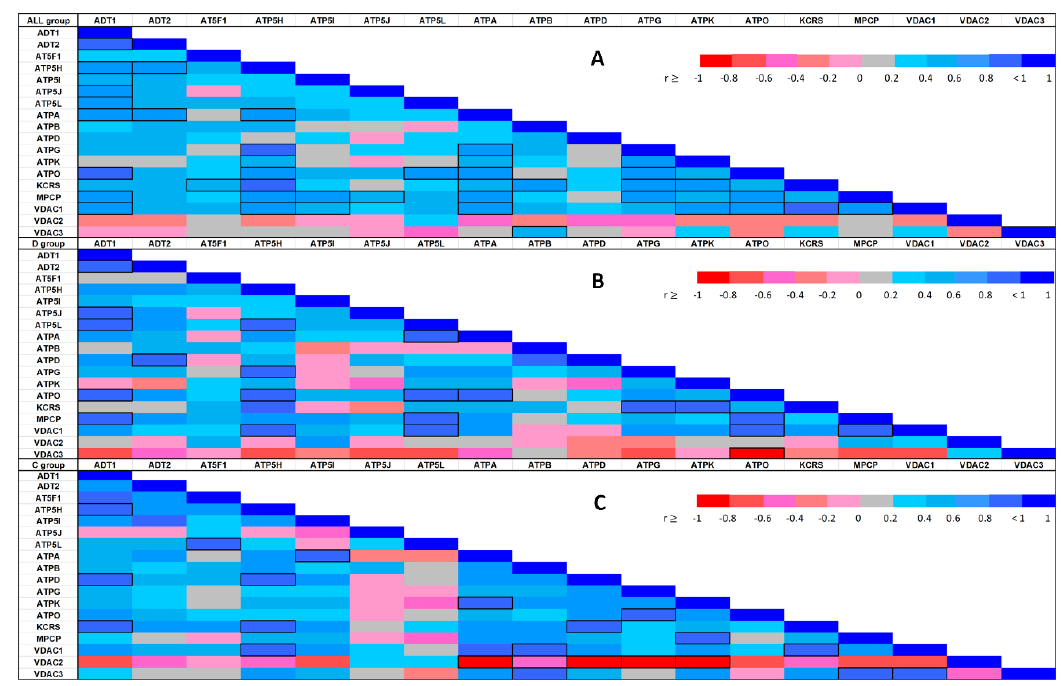
Figure 4. Spearman’s correlation heat-map between each of the identified protein abundances in the whole sample (4 A : upper heat-map) and stratified by experimental condition (4 B : middle heat-map for the diabetic condition; 4 C : lower heat-map for the control group). The color assigned to a point in the heat-map grid indicates the strength of a particular correlation between two protein abundances. The degree of correlation is indicated by red for negative correlations and blue for positive correlations, as depicted in the color key. Statistically significant correlations are marked using cell borders. Note that the upper triangle half of the correlation matrix is symmetrical to the lower triangle half. Thus, there is no need to show the entire matrix.